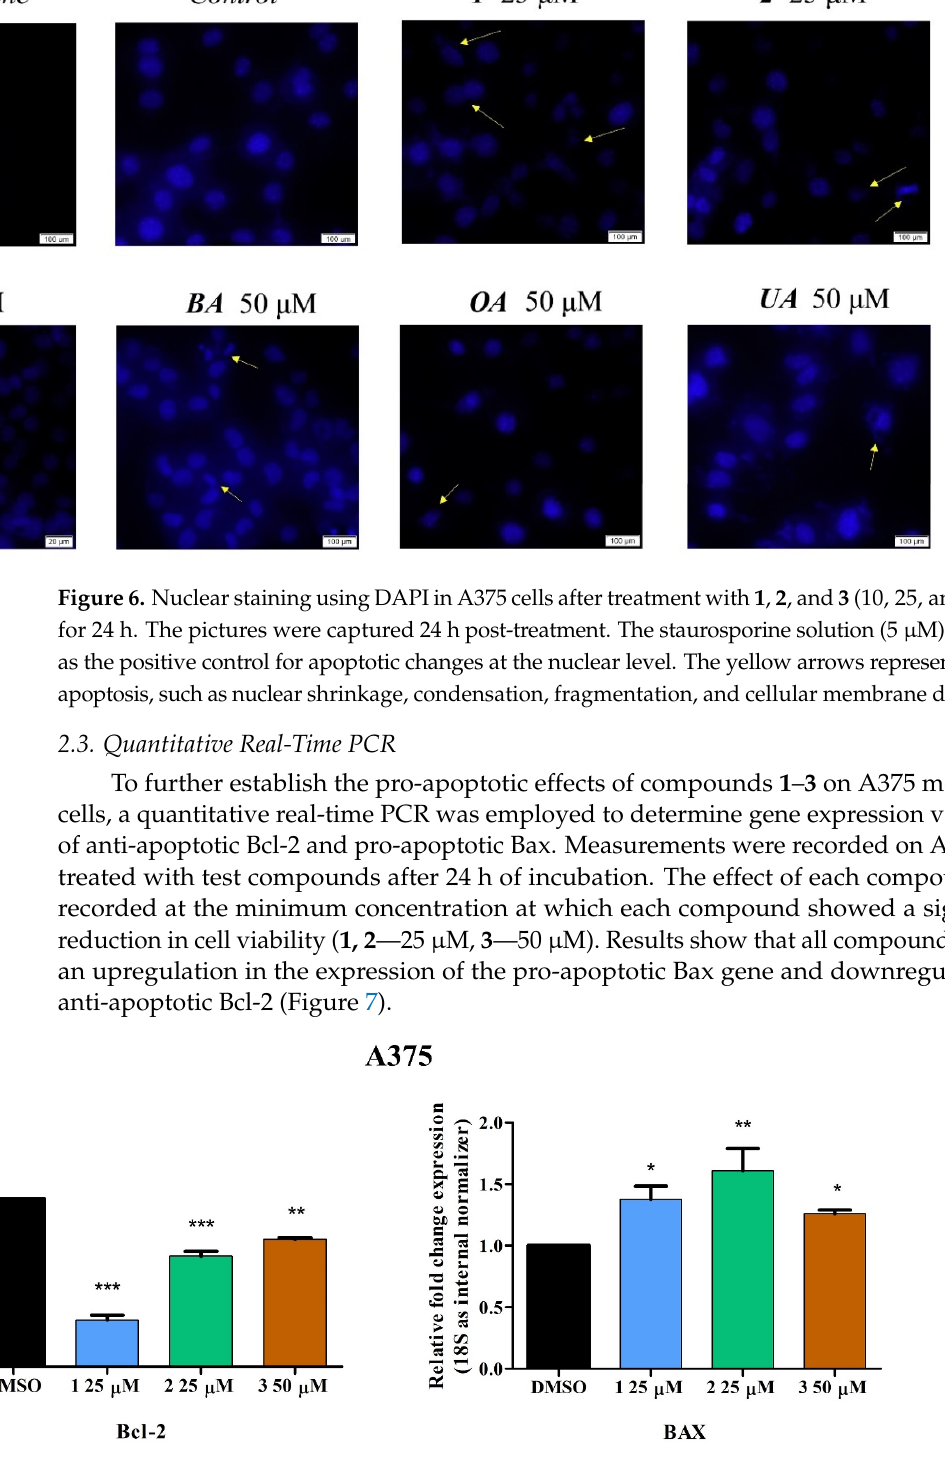
Figure 5. Nuclear staining using DAPI in HaCaT cells after treatment with 1 , 2 , and 3 (10, 25, and 50 μ M) for 24 h. The pictures were captured 24 h post-treatment. The staurosporine solution (5 μ M) was used as the positive control for apoptotic changes at the nuclear level. The yellow arrows represent signs of apoptosis, such as nuclear shrinkage, condensation, fragmentation, and cellular membrane disruption.